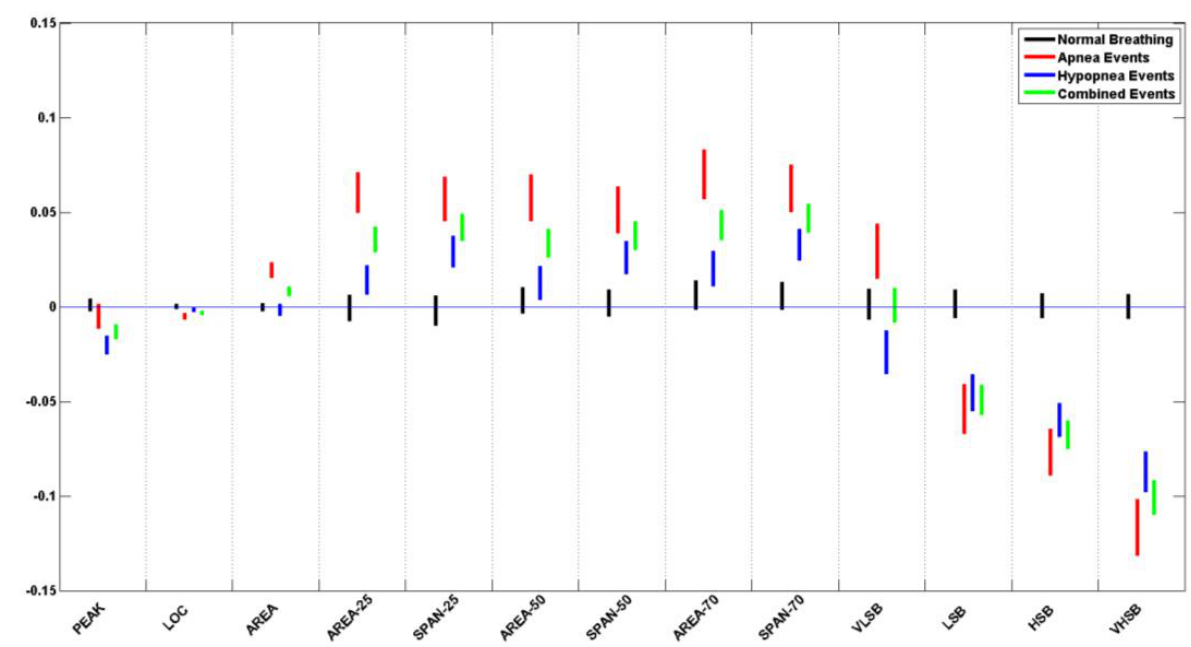
Figure 10. Ratio of means (RM) CI plots for all 13 features of the pooled data from all subjects.